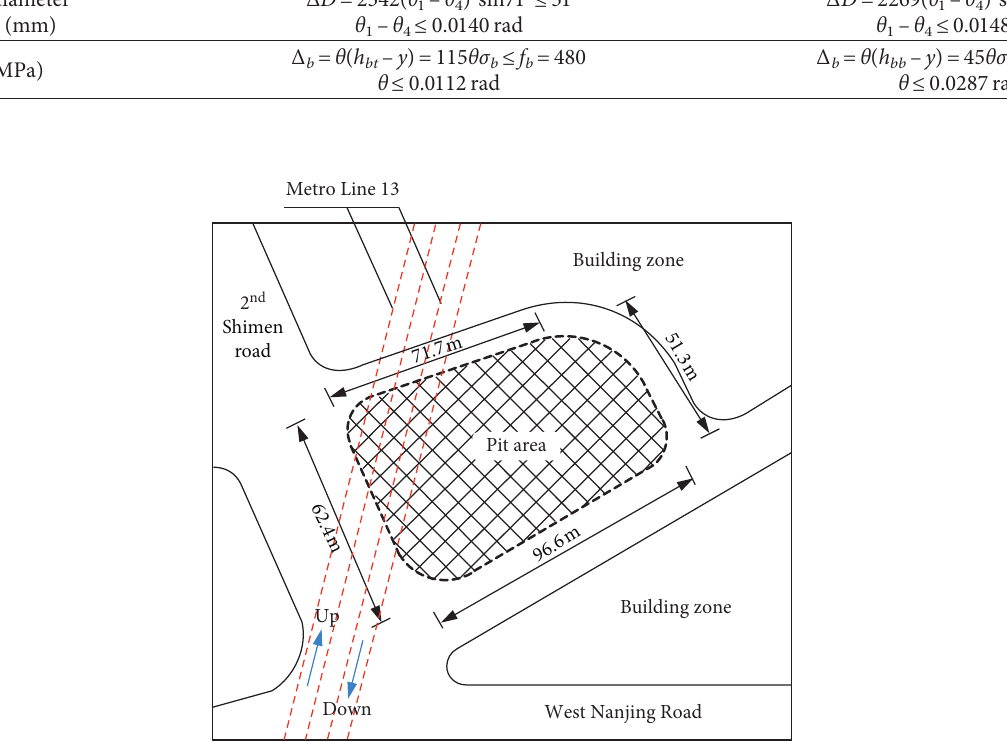
Figure 10: Relative plane location between the pit and the